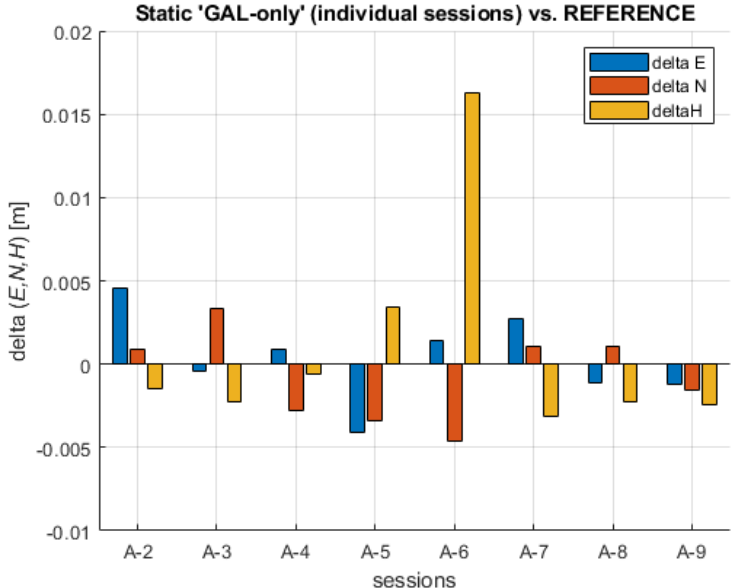
Figure 6. Coordinate differences (delta E, delta N, delta H) between individual static ‘GAL-only’ sessions and the REFERENCE.